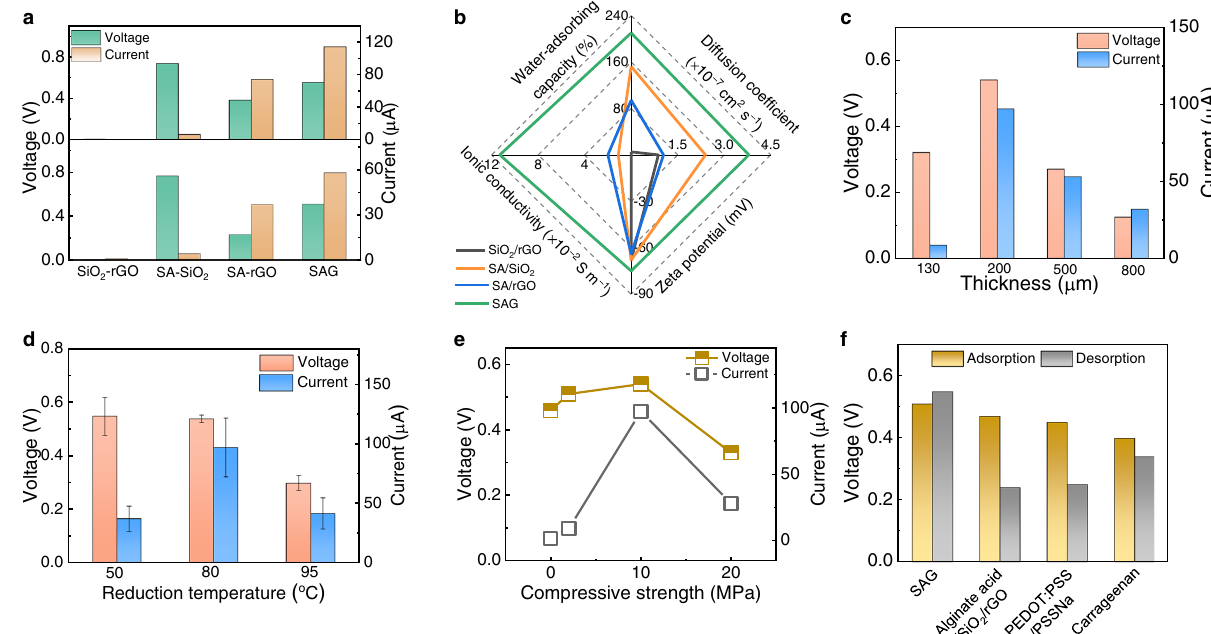
Fig. 4 Factors that in fl uence the electricity-generating performance of MADG. a The electric output of MADGs based on SiO 2 /rGO, SA/SiO 2 , SA/rGO, and SAG fi lm. b Radial plot comparing the water-adsorbing capacity, diffusion coef fi cient of water molecules, zeta potential at pH~7, and conductivity for SiO 2 /rGO, SA/SiO 2 , SA/rGO, and SAG fi lm. Voltage and current output based on SAG fi lm with c different thickness, d reduction temperature and e compressive strength at 90 ± 10% RH and 35 ± 5 o C. Error bars represent the standard deviations from multiple measurements. f Electric output offered by MADGs based on other analogous materials, including alginate acid/SiO 2 /rGO, PEDOT: PSS/PSSNa (that is, sodium polystyrene sulfonate), and carrageenan fi lm.